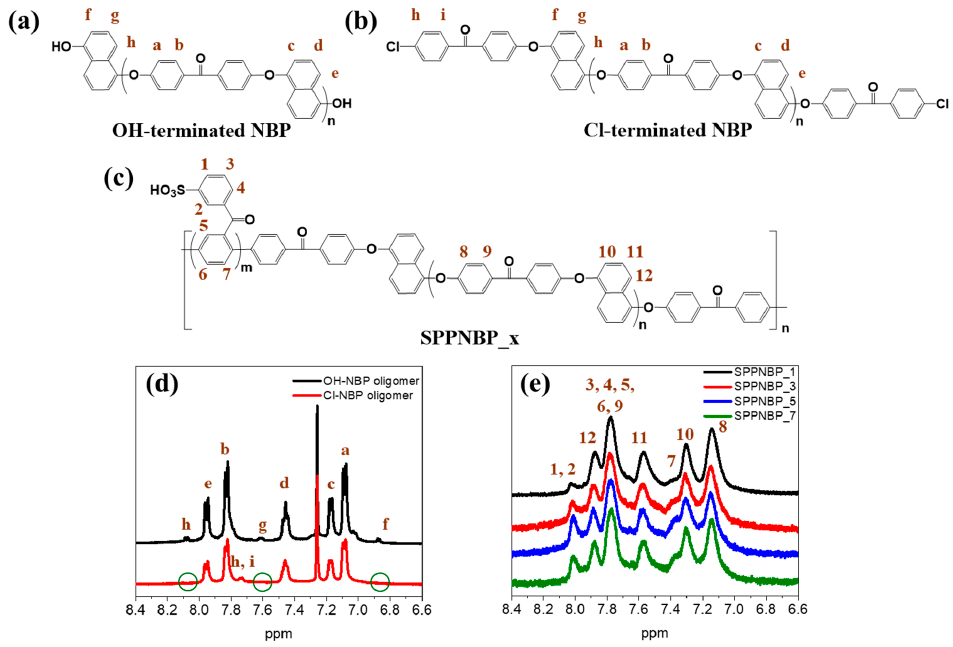
Figure 1. Chemical structures ( a ) OH-terminated NBP, ( b ) Cl-terminated NBP and ( c ) SPPNBP series), 1 H-NMR spectra of ( d ) oligomers and ( e ) SPPNBP_1, 3, 5, and 7.